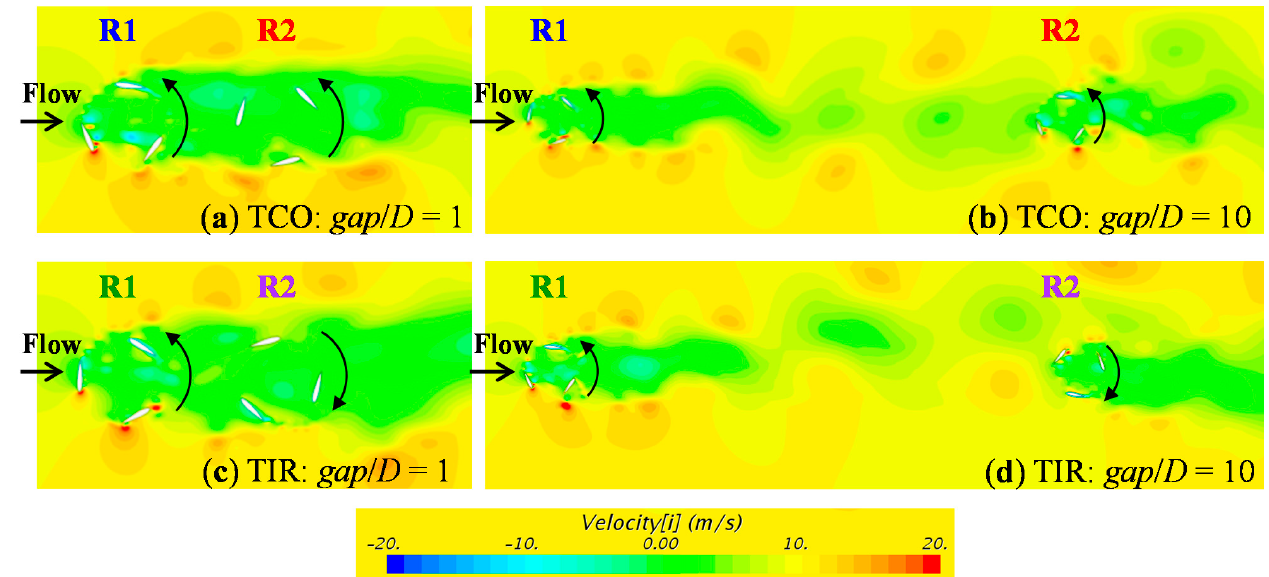
Figure 11. Color contours of flow velocity ( x − direction component): ( a ) TCO layout, gap / D = 1; ( b ) TCO layout, gap / D = 10; ( c ) TIR layout, gap / D = 1; ( d ) TIR layout, gap / D = 10.